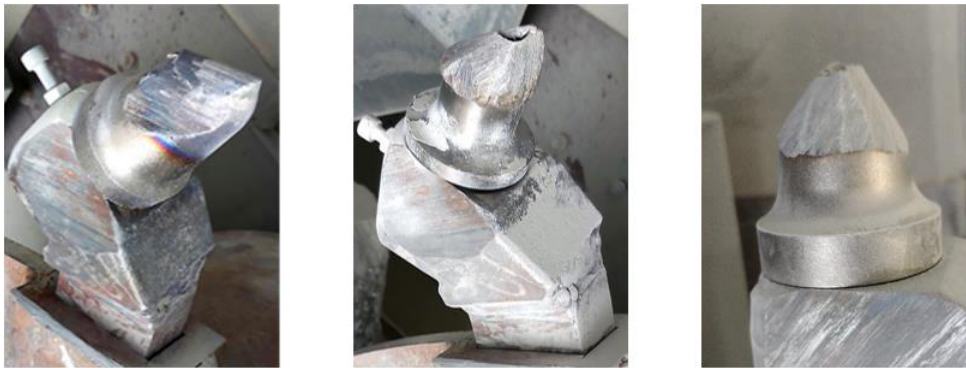
Figure 1. Examples of conical picks’ wear.